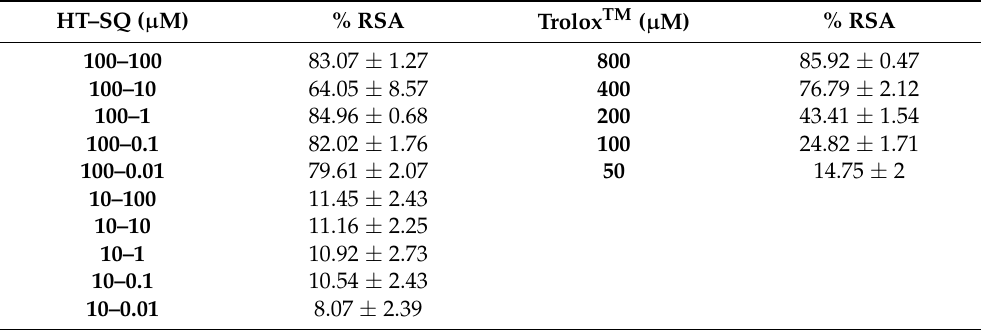
Table 2. Percentage of Free Radical Scavenging Activity of the combination of both HT and SQ and Trolox TM measured by ABTS assay (% RSA at t = 60). Values in the first and third columns represent HT and SQ concentrations, respectively. Values in the fifth column represent Trolox TM concentrations.